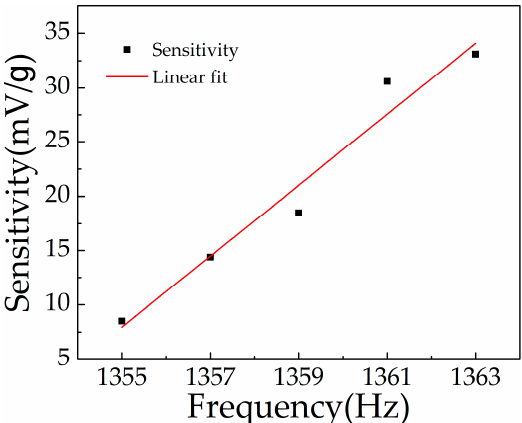
Figure 14. Output voltage of the sensor below resonance frequency.